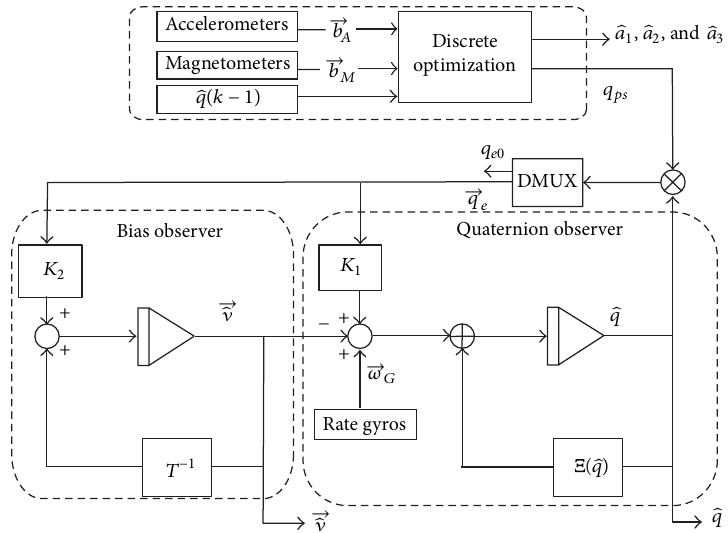
Figure 6: Schema observer ( ⊗ denotes matrix multiplication and ⊗ denotes quaternion